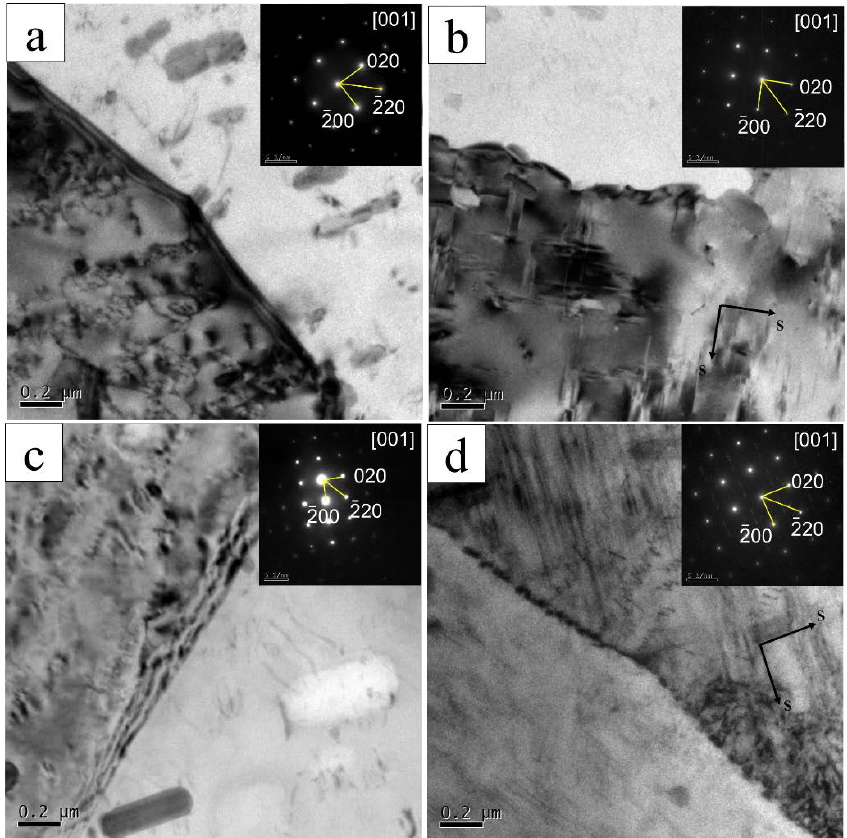
Figure 7. TEM micrographs and corresponding selected area electron diffraction patterns of AA2024 alloy: ( a ) 0.3 mm, initial state; ( b ) 0.3 mm, 12 h aging at 453 K without stress; ( c ) 1.5 mm, initial state; ( d ) 1.5 mm, 12 h aging at 453 K without stress.